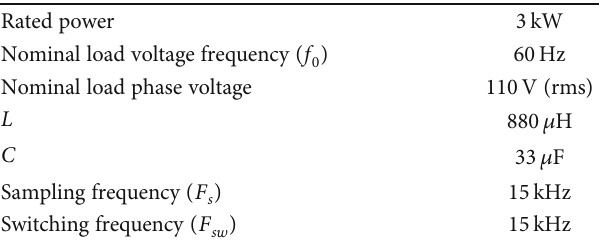
Figure 3: The structure of the proposed hybrid controller. Table 1: The parameters of the experimental test